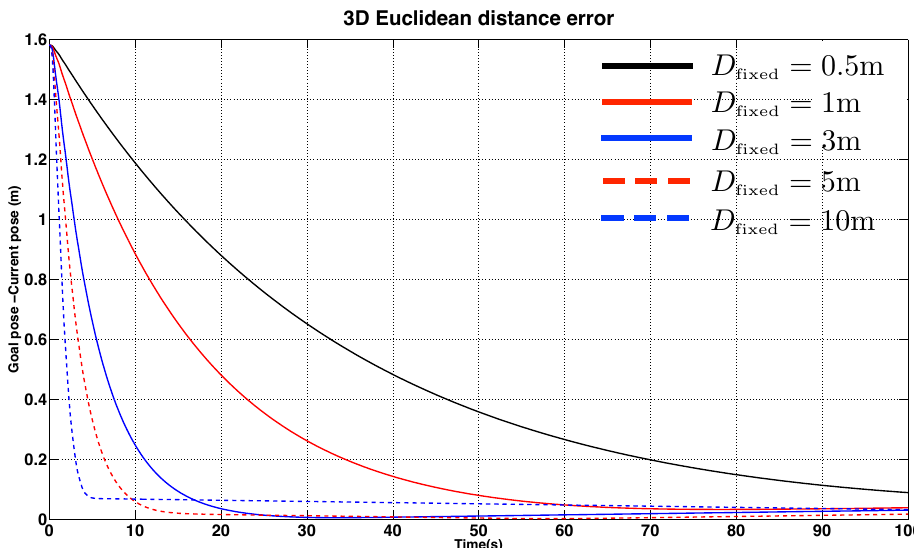
Figure 15. Simulation results for IBVS regulation: error response as a function of time for different assumed constant target object